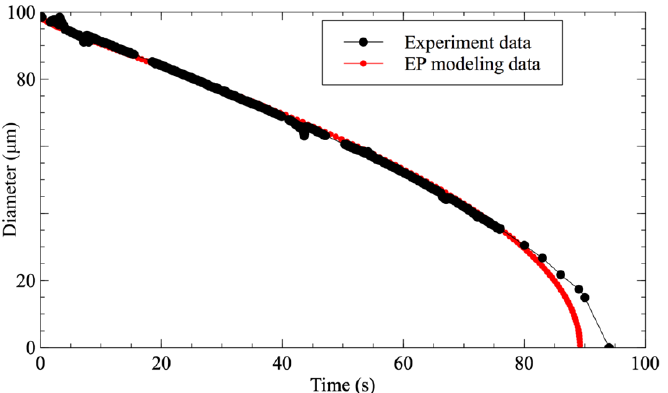
Figure 3. Comparison between the temporal shrinking of water droplets’ diameter in 1-decanol with saturation fraction f = 0.2 (black circle) and the E-P modeling data (red circle).